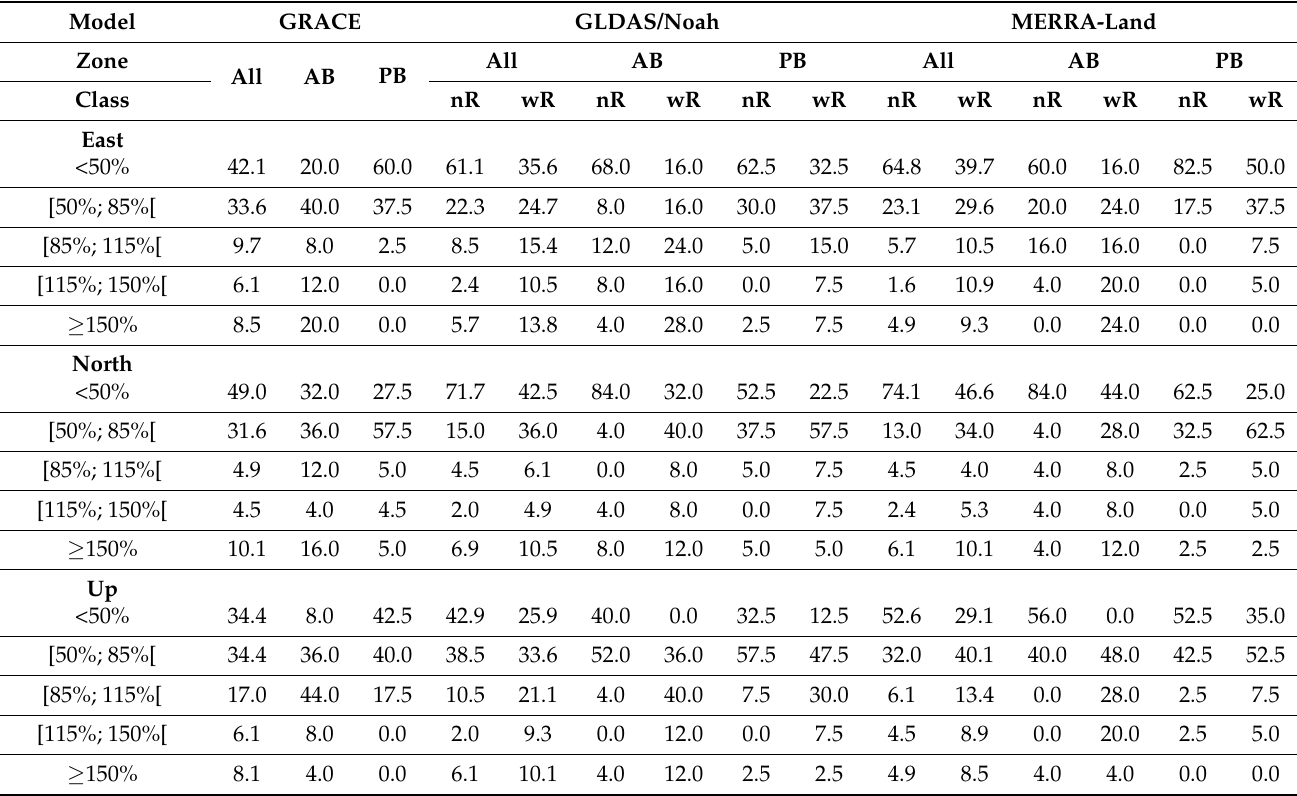
Table 2. Distribution (in %) of the STD ratio between the different models and GPS for different subsets of stations: all stations (247), Amazon basin (25 stations), and Parana (40 stations), designated by the acronyms “All”, “AB”, “PB”, respectively. The loading models without the river are provided in the “nR” columns; the ones including the rivers are in the “wR”